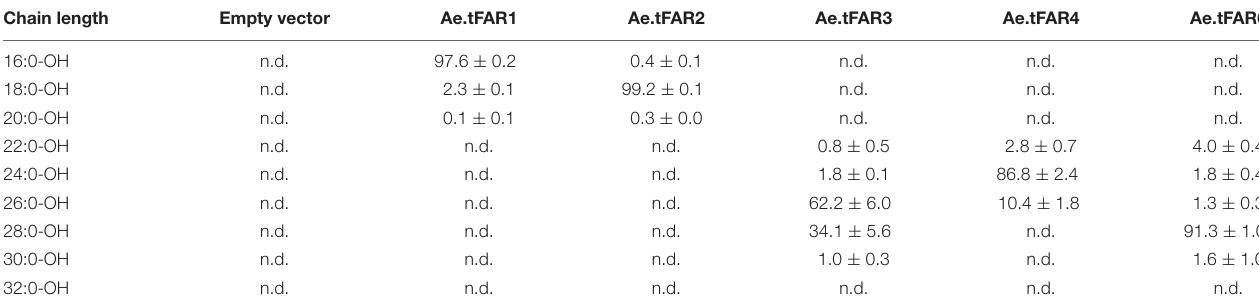
TABLE 2 | Chain length distributions of primary alcohols in yeast expressing Ae.tFARs. Chain length Empty